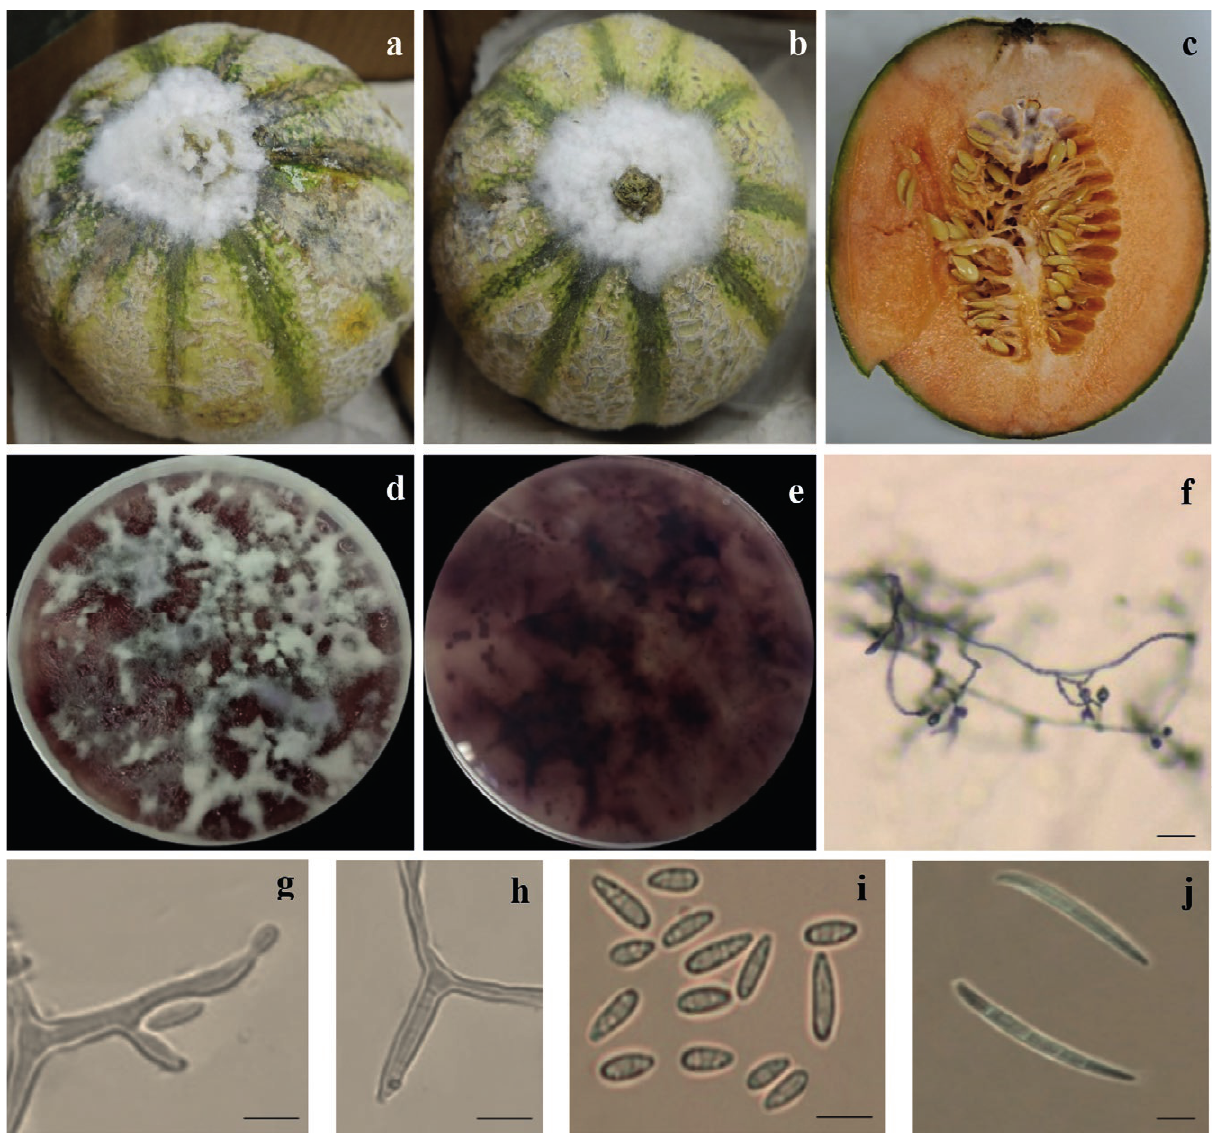
Figure 1. External disease symptoms caused by Fusarium annulatum in cantaloupes aft er natural infections (a, b), and rot of the internal tissues (c). Colony of F. annulatum isolate MLFR-09 on potato dextrose agar aft er 14 d at 26ºC, top view (d) and reverse view (e). Micro- conidial chains (f), polyphialide (g), monophialide (h), microconidia (i) and macroconidia (j). Scale bars: f = 20 µm, g, h, i and j = 10